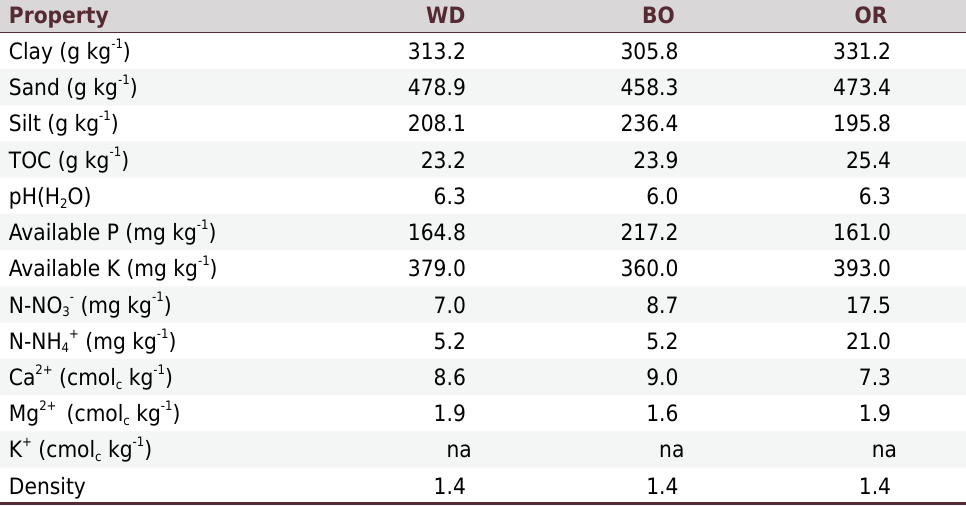
Table 1. Physical and chemical properties at 0.00-0.10 m layer at the installation of the treatments: oilseed radish (OR), black oat (BO), and weeds (WD) Property WD BO